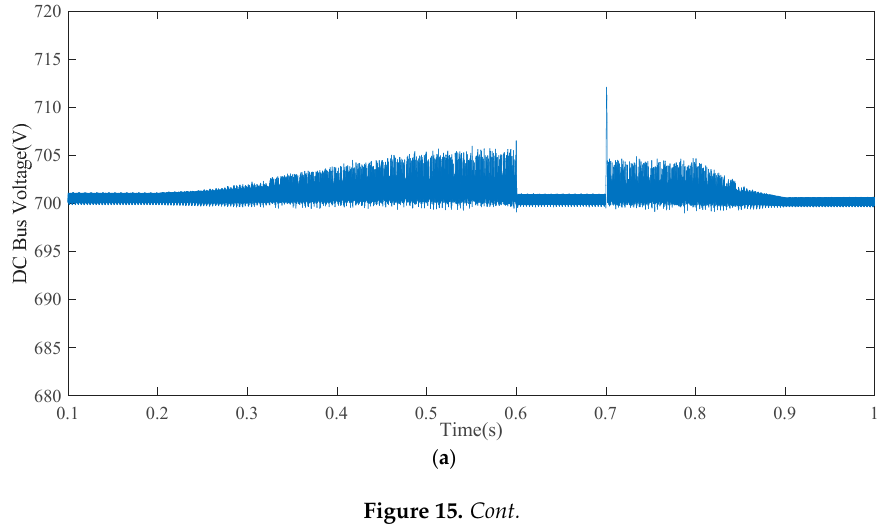
( b ) Figure 15. DC-link voltage and inverter output current: ( a ) DC-link voltage; ( b ) Three-phase output current. The effectiveness of the MPPT method presented in this paper is shown in Figure 15b. The output current is consistent with the PV output characteristic curve in Figure 4. 5.2. Simulation Case 2 In order to evaluate the performance of proposed method under extreme partial shading conditions, different control methods and algorithms which presented in simulation case 1 are tested